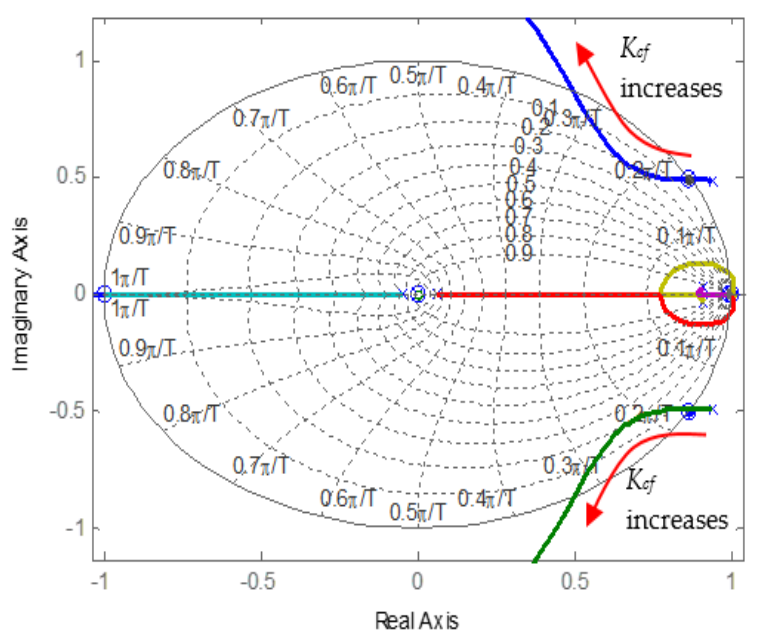
Figure 11. Root locus of variation in active damping gain K cf using a dual-loop controller.